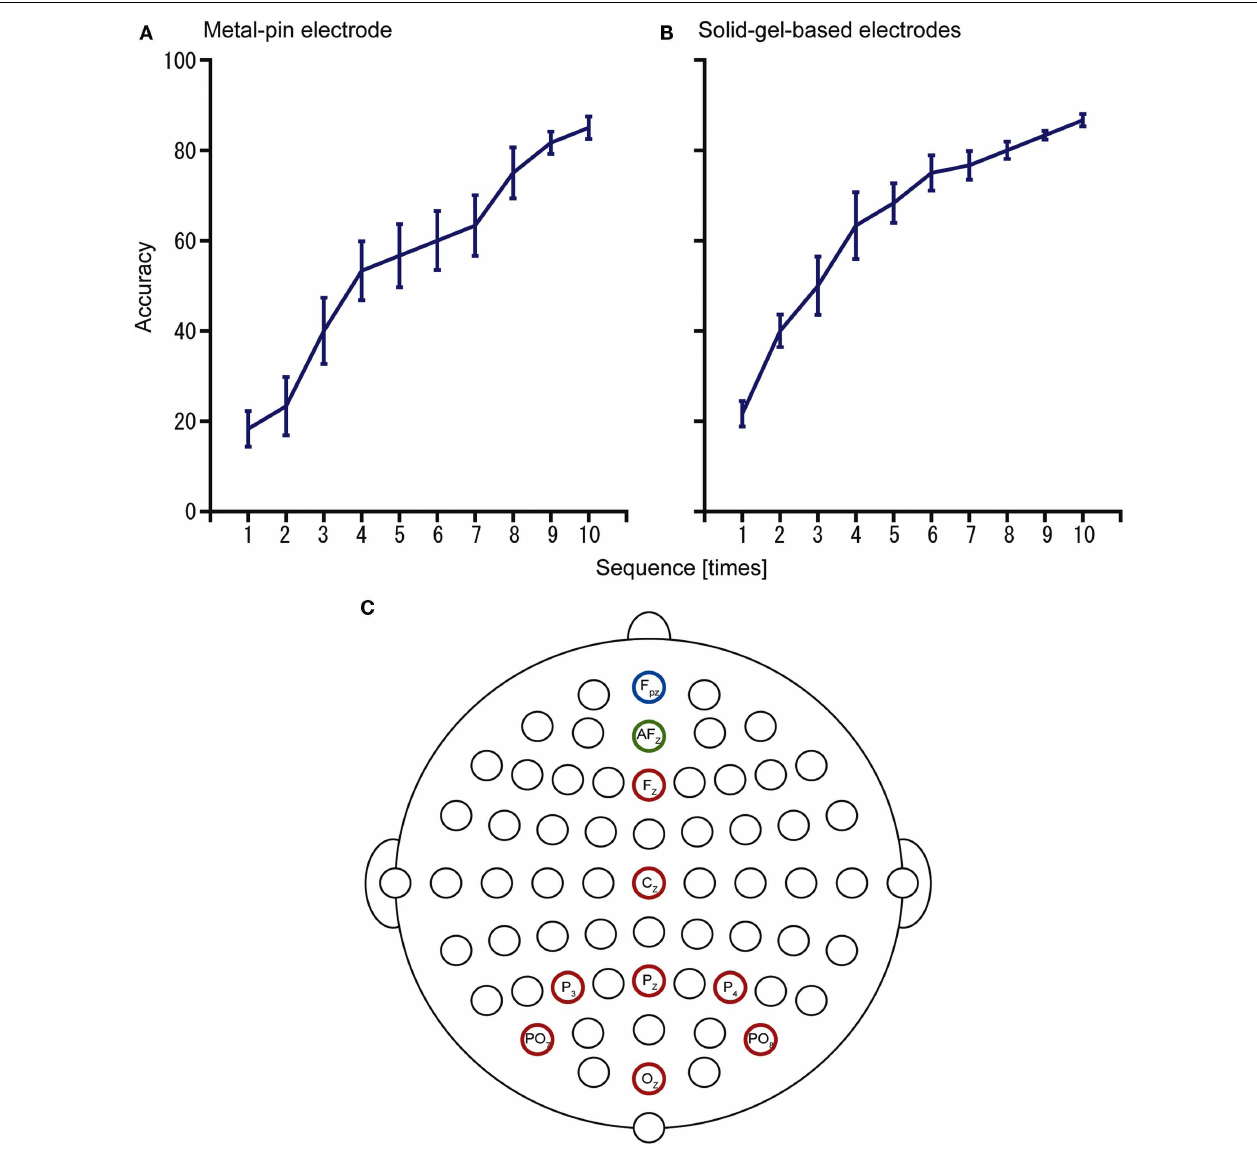
FIGURE 6 | Results of the P300-brain–machine interface (BMI) experiments using (A) metal-pin electrodes and (B) solid-gel-based electrodes. The configuration of electrodes is represented in (C) . Data were obtained from the same participants ( n =